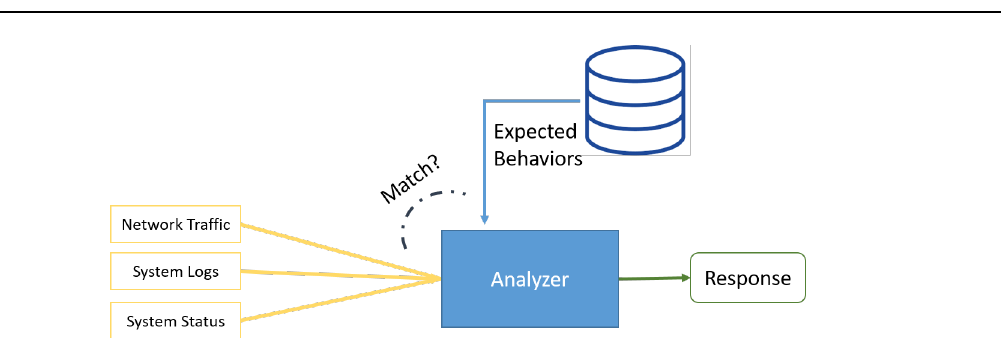
Figure 2. Diagram of a generic signature-based